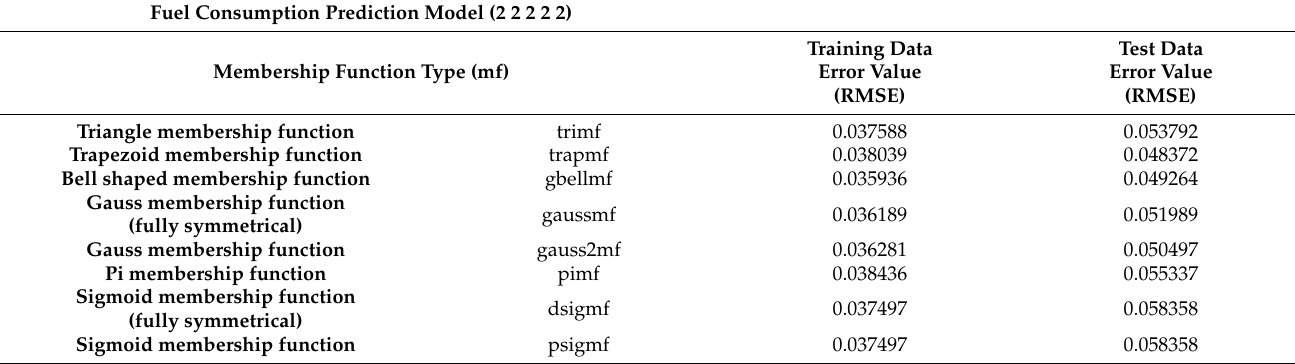
Table 10. The characteristics of the best structure